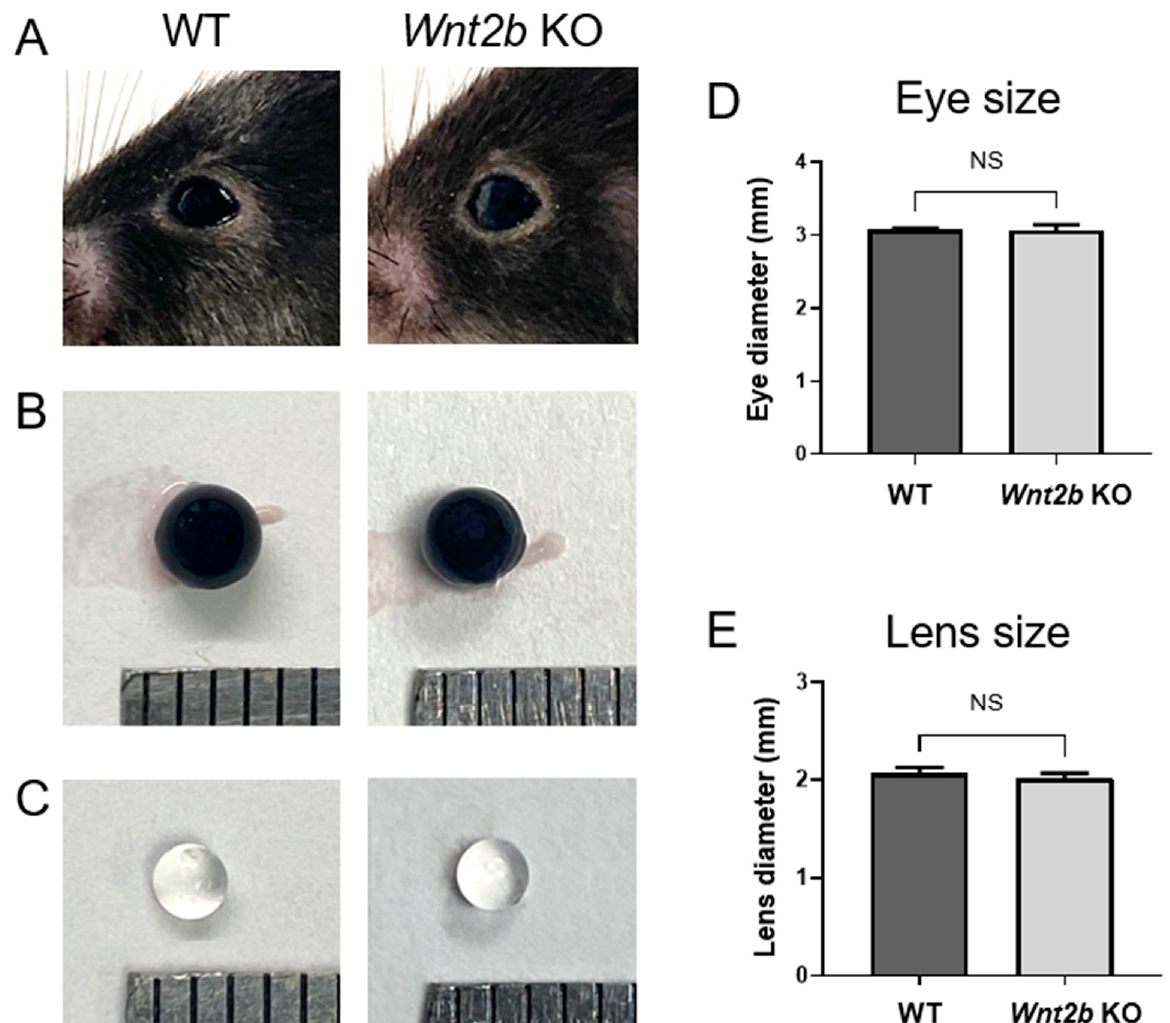
Figure 1. Wnt2b KO mice have normal anterior segments with comparable eye and lens sizes. ( A – C ) Representative images of mouse eyes’ exteriors ( A ), isolated whole eyeballs ( B ) and lens ( C ) from 1-month-old WT and Wnt2b KO mice. ( D , E ) Quantification of the diameters of isolated whole eye- balls ( D ) and lens ( E ). Scale: each grid is 1 mm. Data presented as mean ± SD; n = 4–8 eyes/group; NS: not significant.